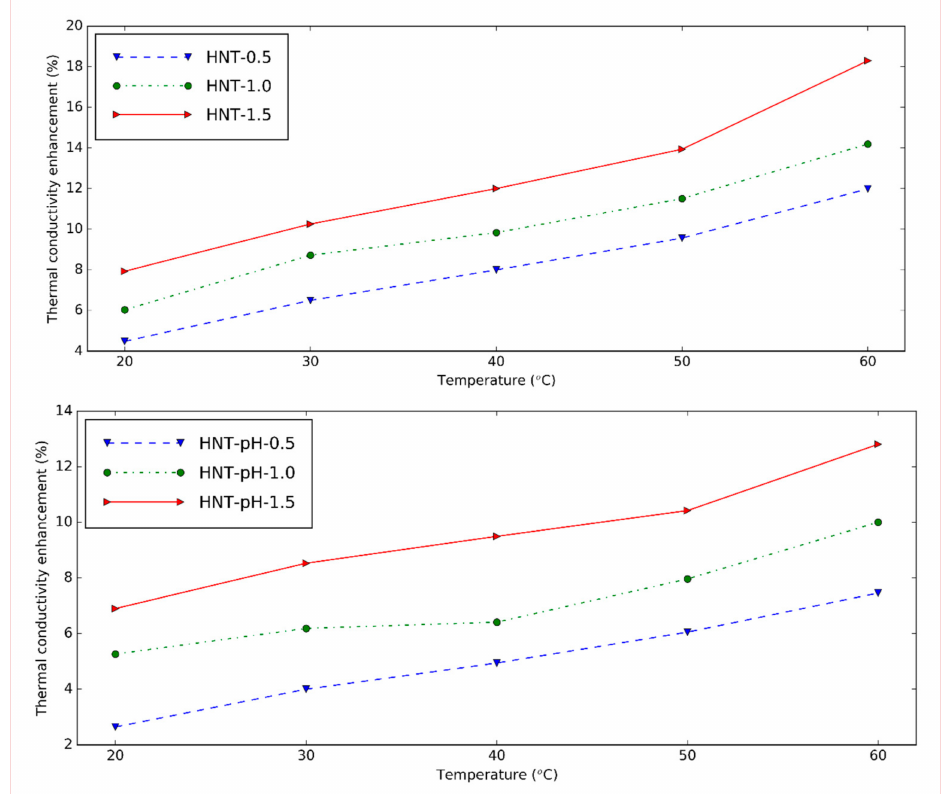
Figure 8. Thermal conductivity and enhancement of thermal conductivity of halloysite nanofluids at di ff erent temperatures (upper: changing pH, lower: using